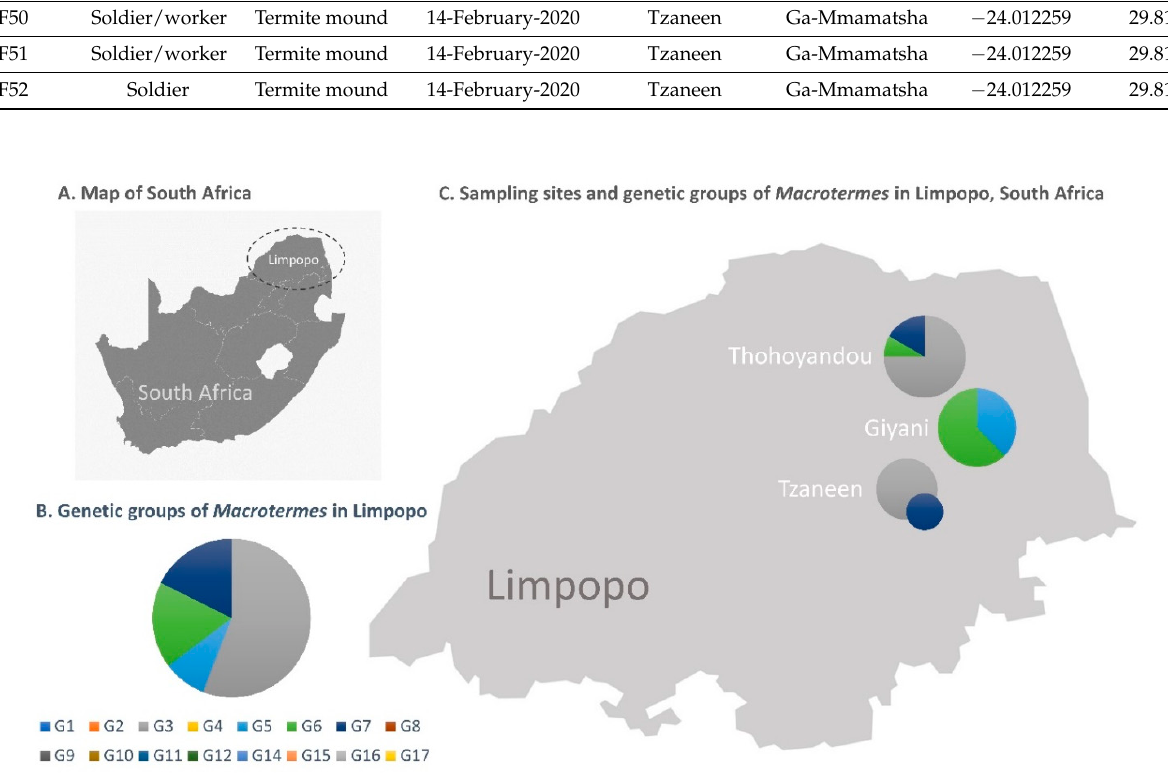
Figure 1. ( A ) Map of South Africa. ( B ) Genetic groups of African Macrotermes species. ( C ) Approximate location of the collection sites of Macrotermes termites in the Limpopo Province of South Africa, and their mitochondrial genetic groups. The size of the circles is proportional to the number of sequences.